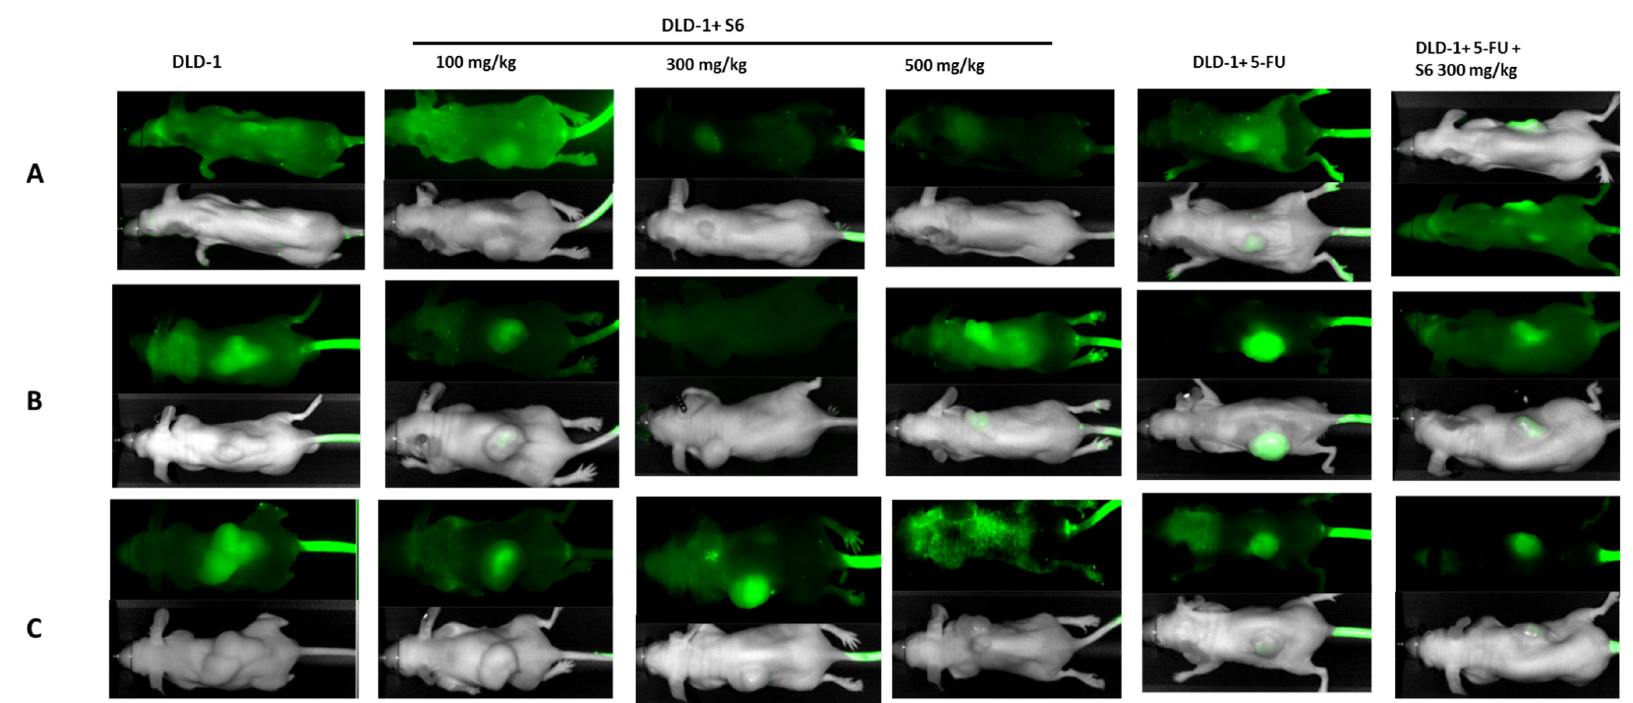
Figure 3. Imaging of the tumor sizes during administration of S6 for 28 days in the study groups on the 1st ( A ), 14th ( B ), and 28th ( C ) day using the Pearl system.